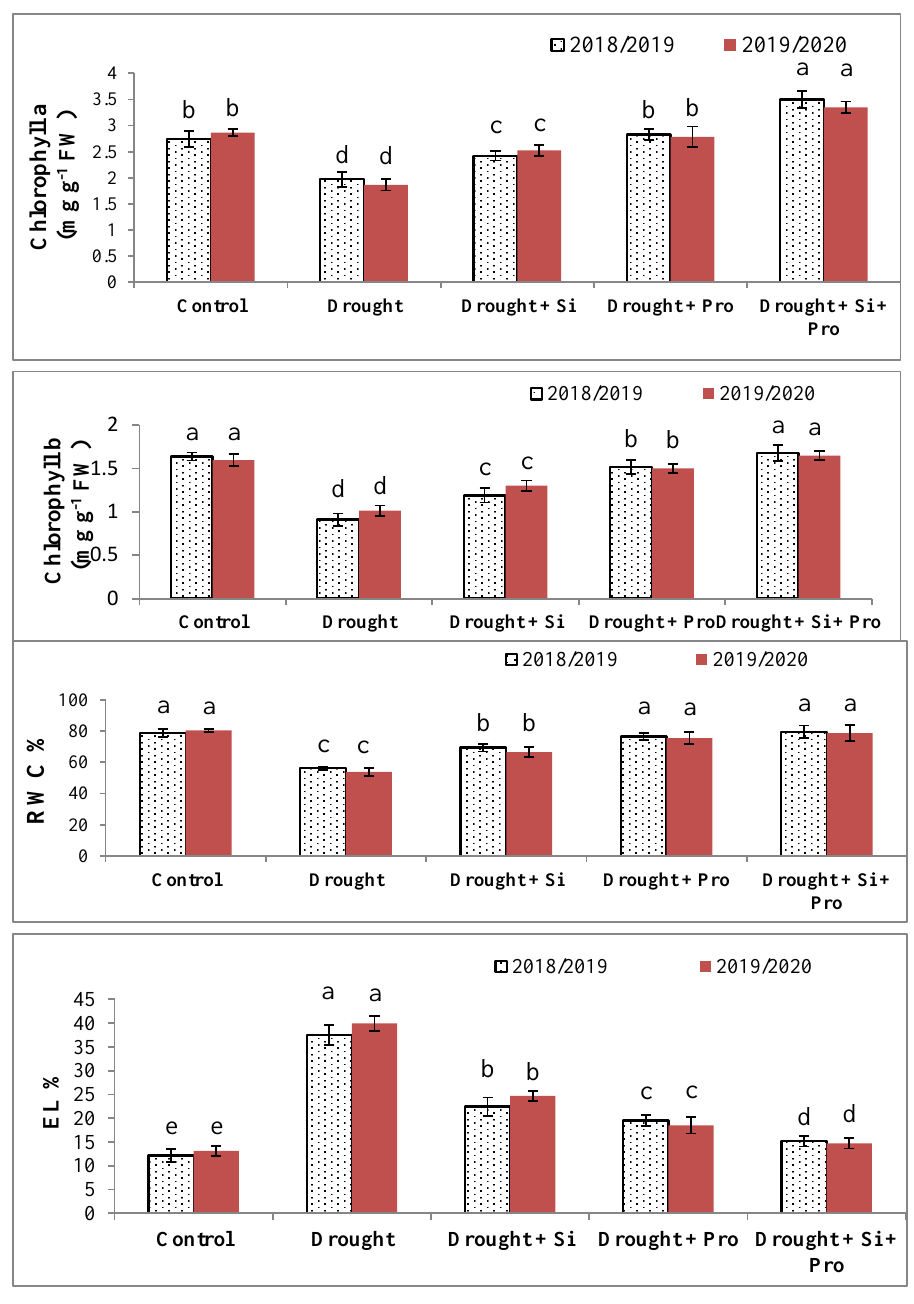
Figure 3. Effect of silicon and proline on Chlorophyll a ( A ), Chlorophyll b ( B ), relative water content Fig. 3 (RWC)% ( C ) and electrolyte leakage (EL)% ( D ) of sugar beet plants under drought in 2018/2019 and 2019/2020 seasons. Bars followed by different letters are significantly different according to Duncan’s multiple range tests (DMRTs) at p < 0.05. Si: Silicon, Pro: